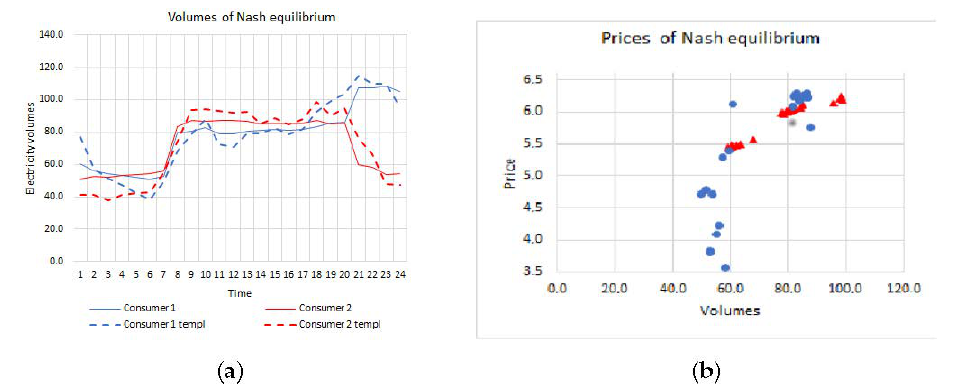
Figure 5. The Nash equilibrium pricing. The ( a ) optimal load and ( b ) prices.